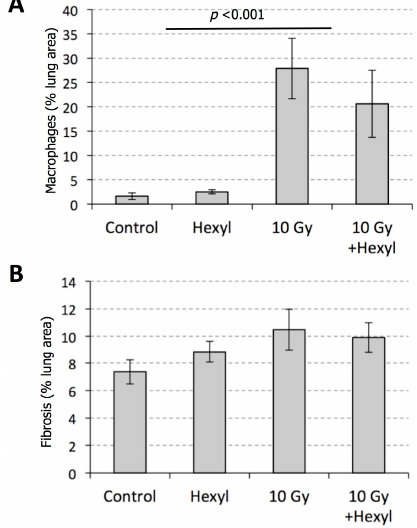
Figure 8. Pulmonary histomorphometry. ( A ) The main effect of radiation was significant ( p < 0.001) for macrophages expressed as % area of the lung staining for human alveolar macrophage 56 (HAM56) antigen. ( B ) Pulmonary fibrosis was not statistically increased during the course of this experiment.